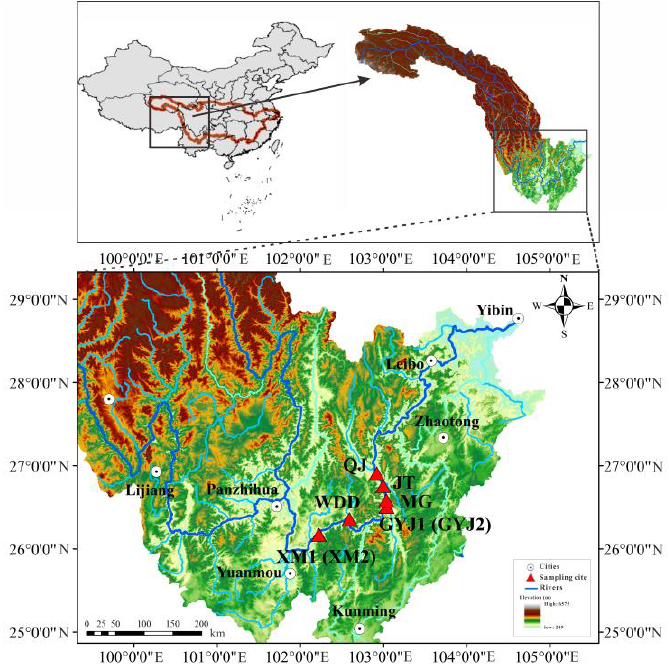
Figure 1. Map showing the study area and sampling locations.